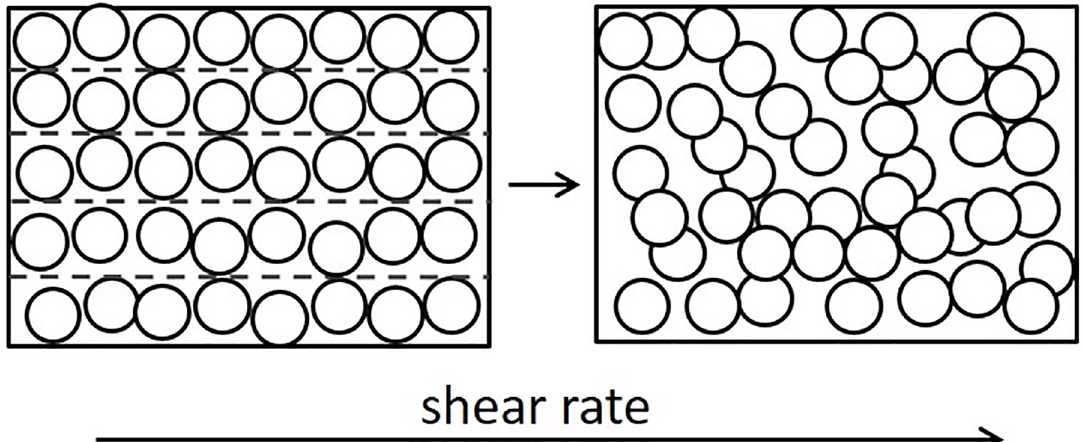
Figure 2. Scheme illustrating mechanism of order-disorder